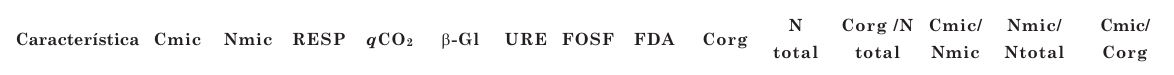
de milho e do solo da área adjacente, coberta com Brachiaria sp. (1)